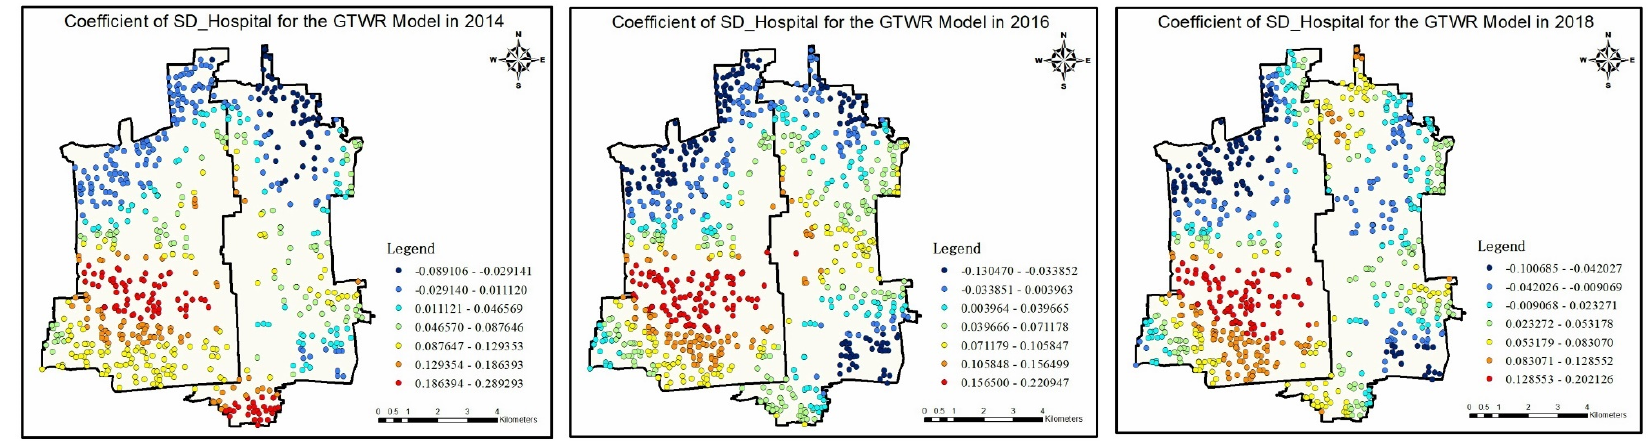
Figure 8. Coefficient of SD_Hospital for the GTWR model in 2014, 2016, and 2018.